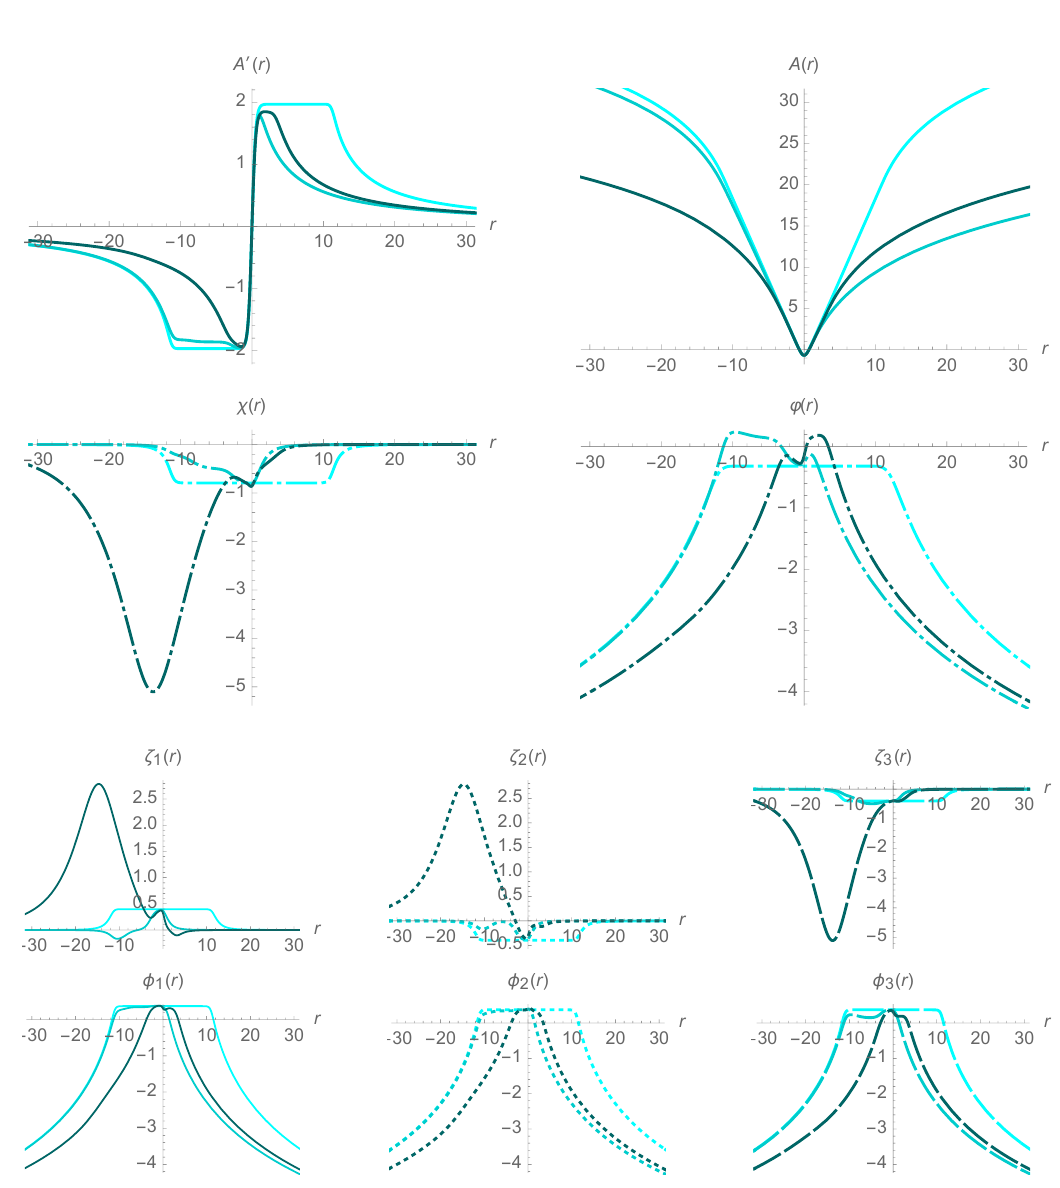
Figure 21. SYM/SYM (dark blue), SO(4) / SO(4) (light blue) and SYM/ SO(4) (blue) N = 1 Janus solutions with SO(3)